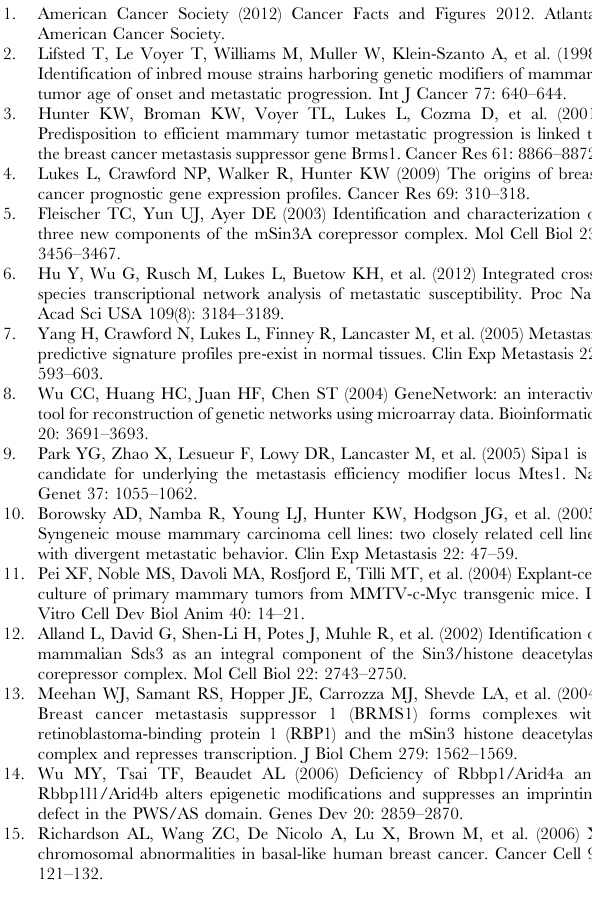
Figure S3 High resolution map of Tpx2 network gene expression in Arid4b knockdown cell lines. Red indicates statistically significant (p , .05, ANOVA) downregulation; green indicates upregulation. (TIF) Figure S4 ARID4B mRNA expression in ductal breast carcino- ma versus normal breast tissue. Dots represent minimum and maximum values, whisker bars represent 10 th and 90 th percentiles, boxes represent 25 th to 75 th percentiles, and center bars represent median values. Fold change was 2.299 and statistical significance was determined by two-tailed t-test. Figure adapted from Oncomine representation of ARID4B expression in the Richardson breast cancer data set [15]. (TIF) Table S1 Arid4b exon amplification and sequencing